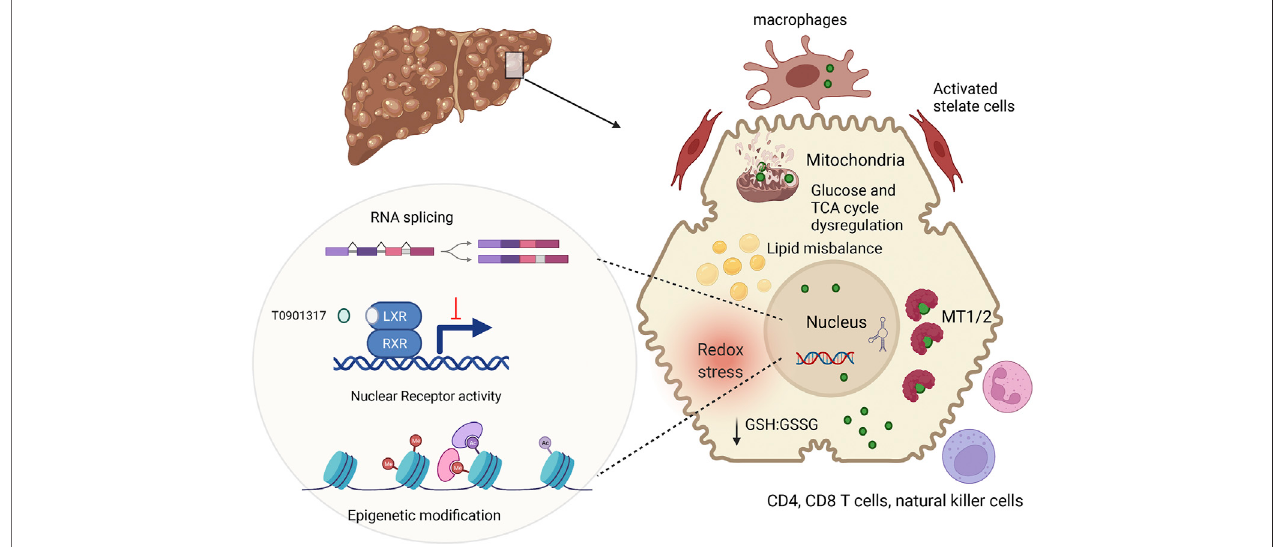
FIGURE 2 | Summary of main pathologic changes in WD liver. ATP7B mutations result in hepatic accumulation of copper (green circle). In the cytosol, Cu is sequesteredbymetallothioneins(MT1/2),whereasexcessCucausesglutathioneoxidation(lowerGSH:GSSGration),contributingtoredoxstress.Cuelevationinnuclei, alters RNA processing, including splicing (Burkhead et al., 2011) inhibits NR function and induces epigenetic changes. Downstream effects include dysregulation of metabolic pro fi les in hepatocytes. Hepatocyte injury and possibly Cu accumulation in non-parenchymal cells stimulates immune cells and stellate cells, resulting in in fl ammation and fi brosis. The fi gure was generated using